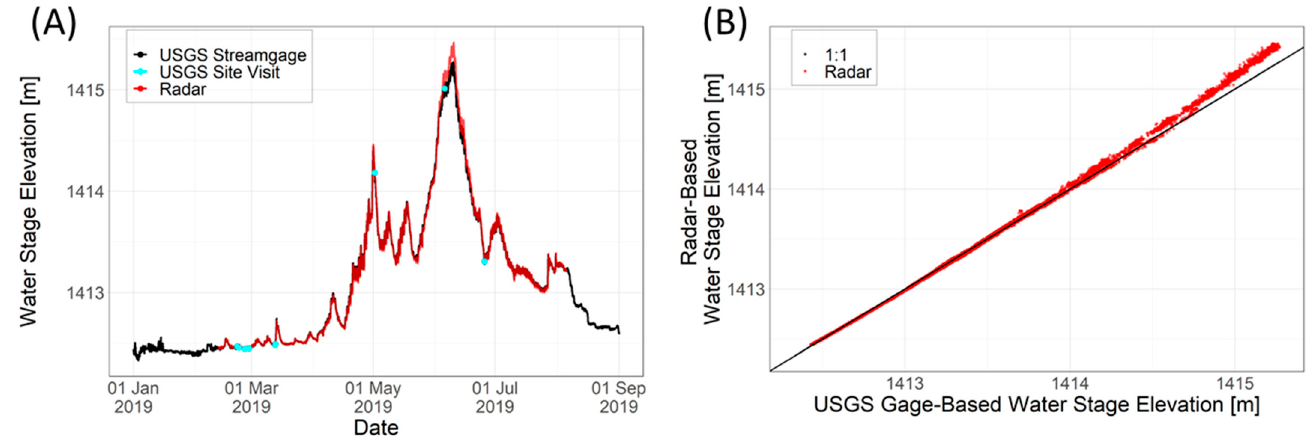
Figure 4. Comparisons of radar-based stage data (red), continuous USGS-streamgage-based stage data (black), and USGS site visit stage data (cyan), that include ( A ) a time series of all datasets and ( B ) a scatterplot of radar-based stage data vs. USGS continuous streamgage-based data. Elevation data are in meters above NAVD 88.